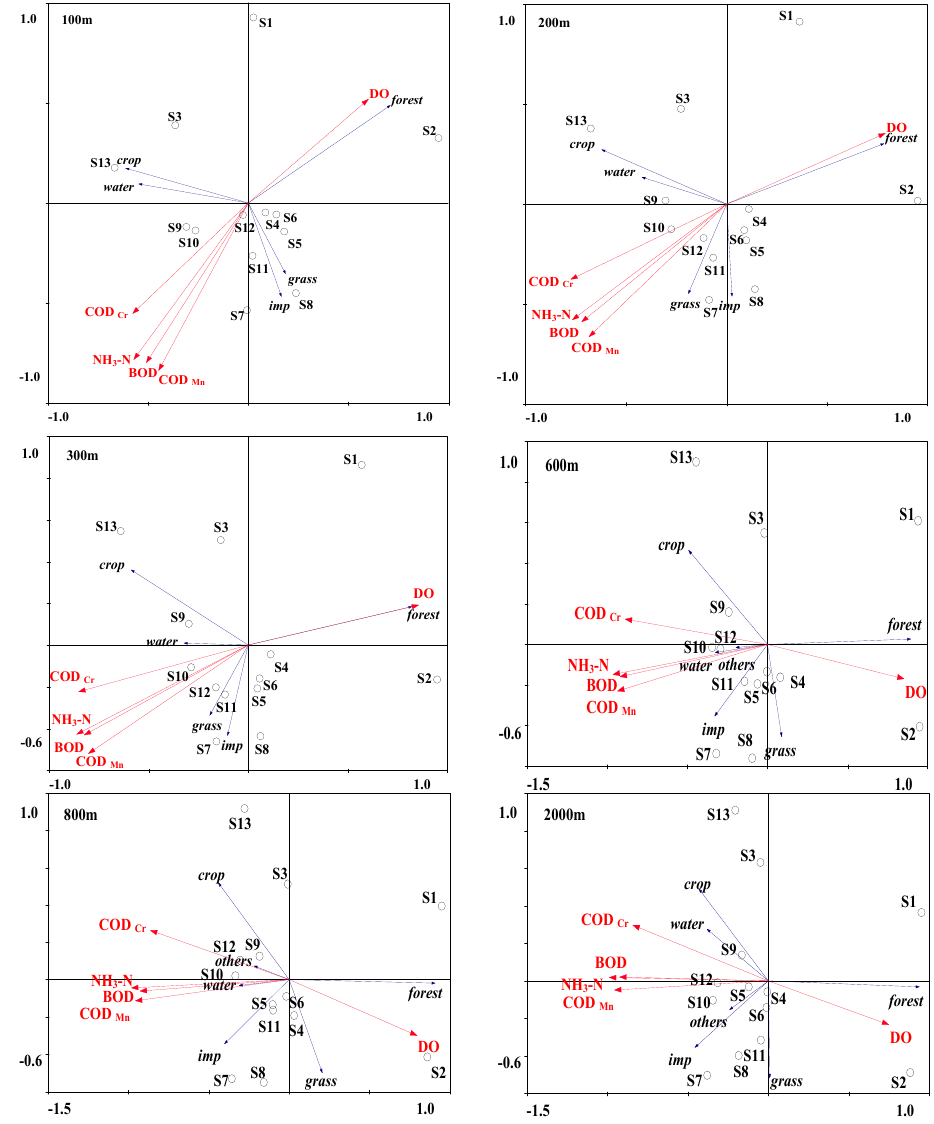
Figure 7. RDA results of LULC and water quality variables within the buffer of 100 m, 200 m, 300 m, 600 m, 800 m, and 2000 m. “imp” means impervious surface. Table 2. Summary of RDA of LULC with respect to the five environmental variables (ENVI) at buffers of 100–2000 m.